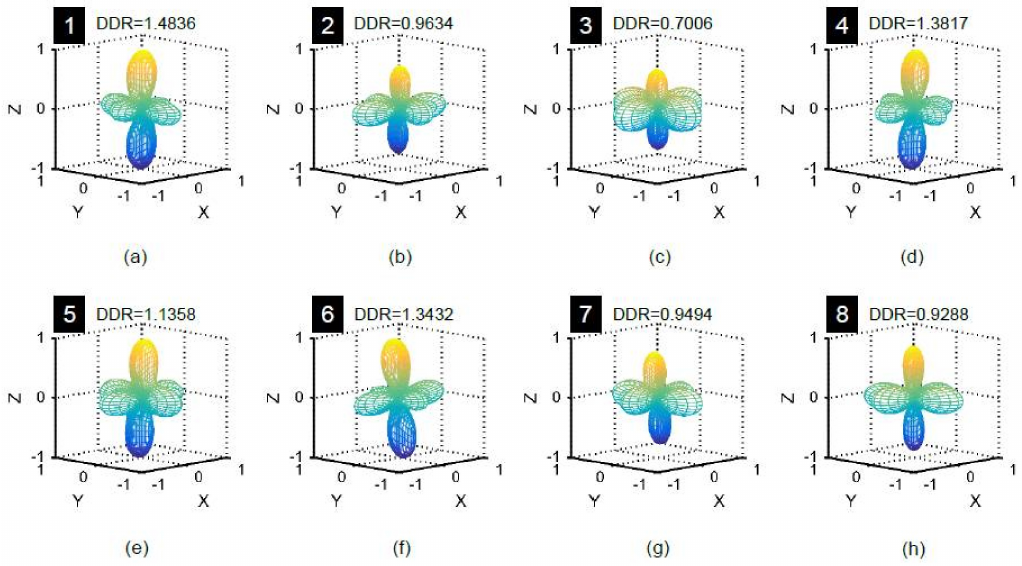
Figure 23. 4th order approximation of distribution density for contact normal vectors within selected regions of interest around particles at vertical stress of 8 MPa (numbers with black background represent the particle IDs of Figure